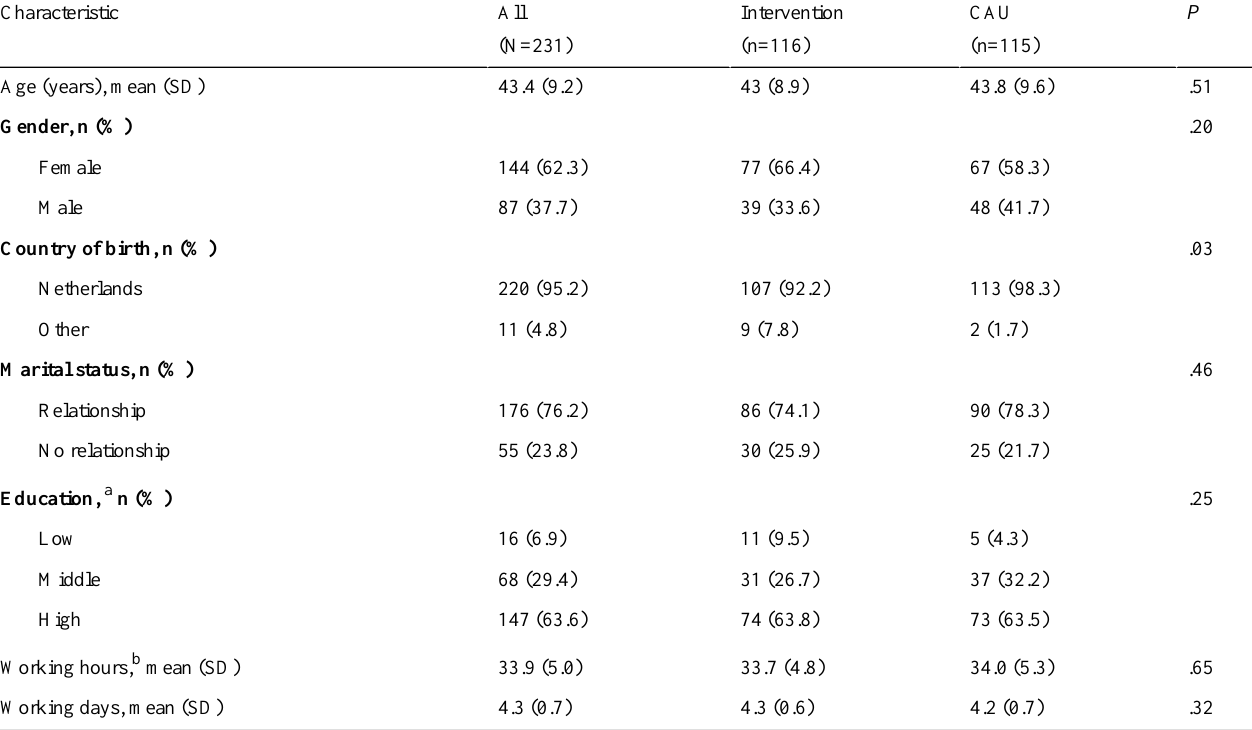
Table 1. Participants’demographic characteristics at